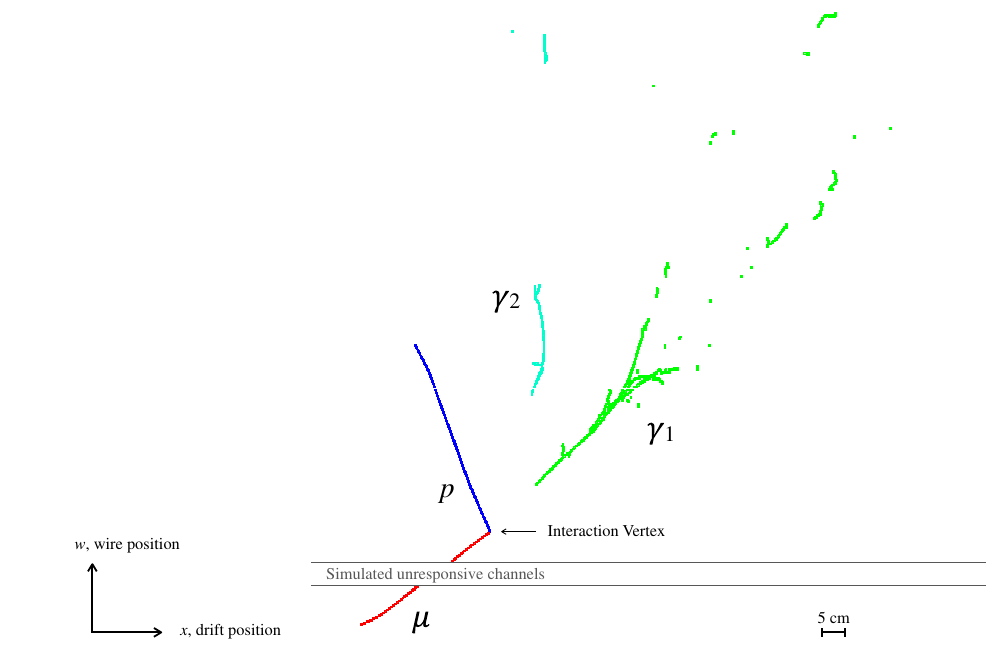
Fig. 17 The reconstruction of a simulated 1.4-GeV CC ν μ interaction with resonant neutral-pion production. Target particles for the recon- struction are the muon, proton and two photons from π 0 decay. The